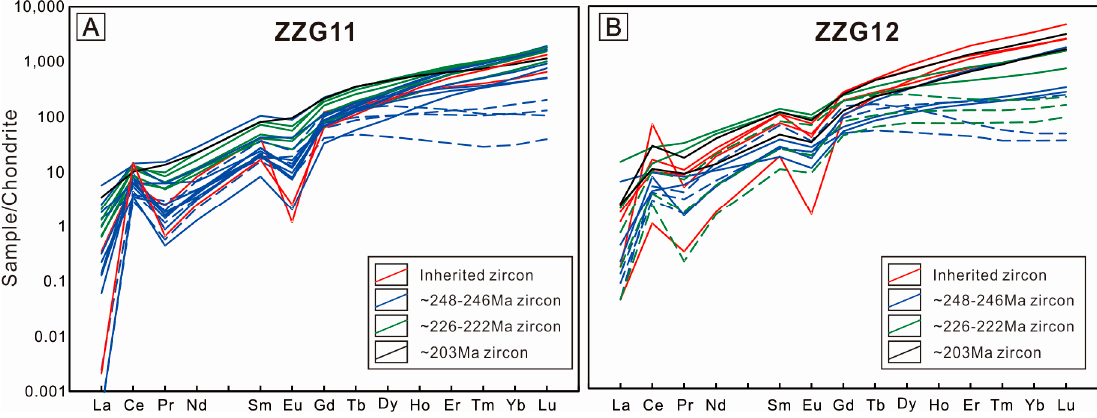
Figure 8. Chondrite-normalized REE patterns for ZZG11 ( A ) and ZZG12 ( B ). Note the HREE value anomalies (dashed lines) which may be indicative of contamination by inclusions or alteration.